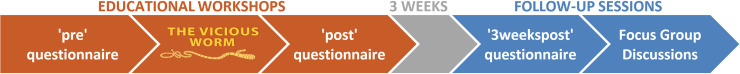
Simplified study timeline.Observational data were collected throughout the seven-week study period.